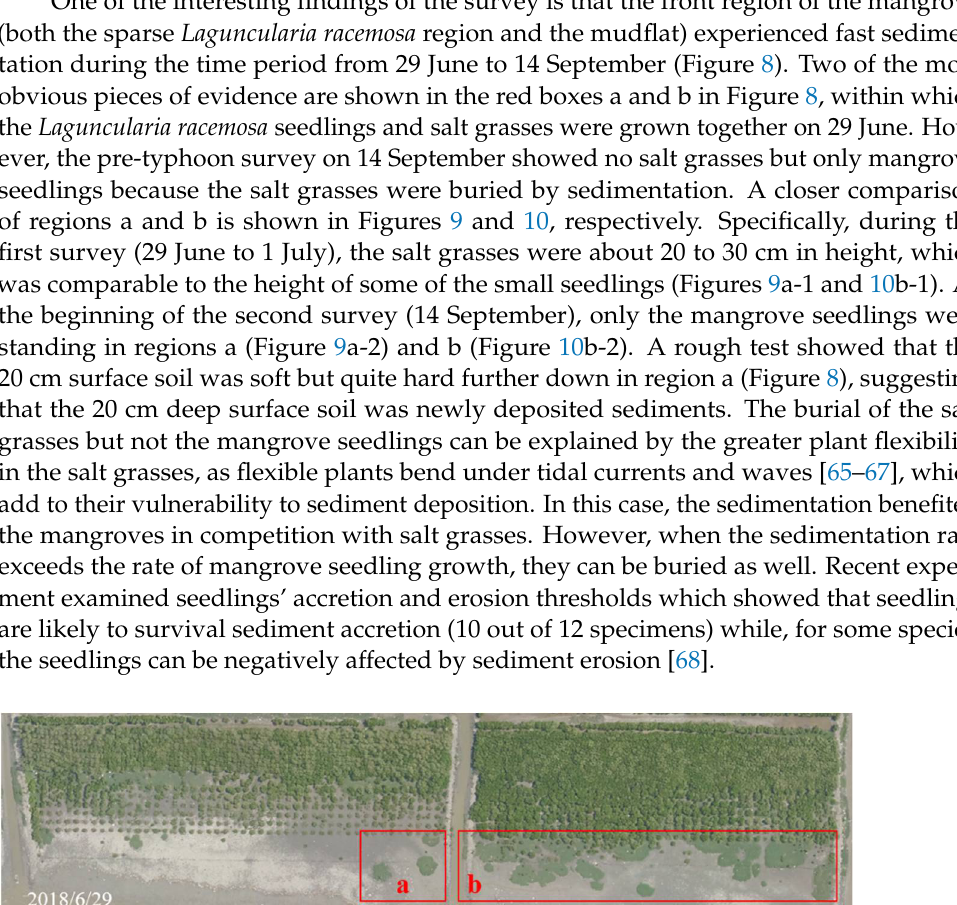
Figure 9. Comparison of tidal flats with both mangrove seedlings and salt grasses in region a (red box a in Figure 8) on June 29 ( a-1 ), September 14 ( a-2 ), and September 18 ( a-3 ), during which obvious sedimentation occurred in this region.